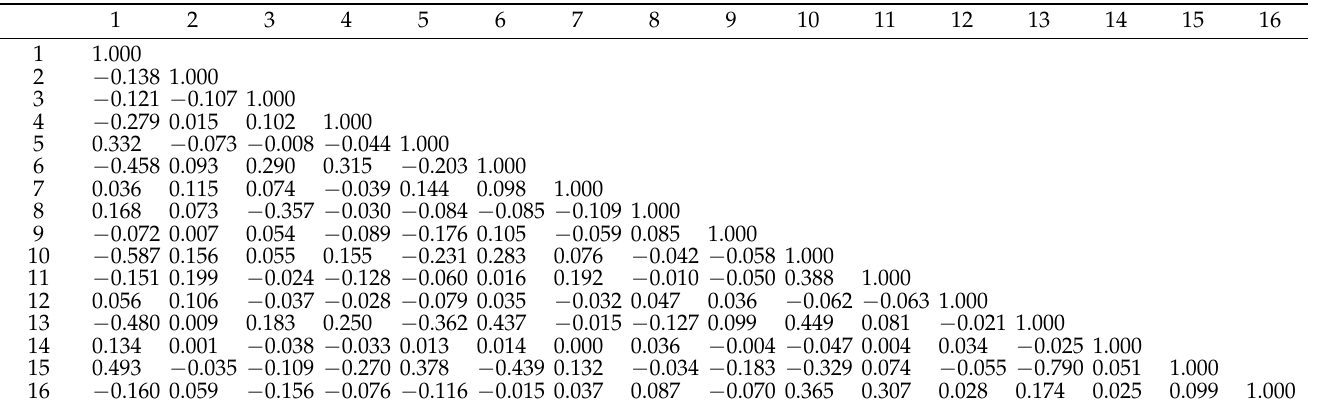
Table 2. Pearson correlation coefficient of landslide susceptibility assessment factors.